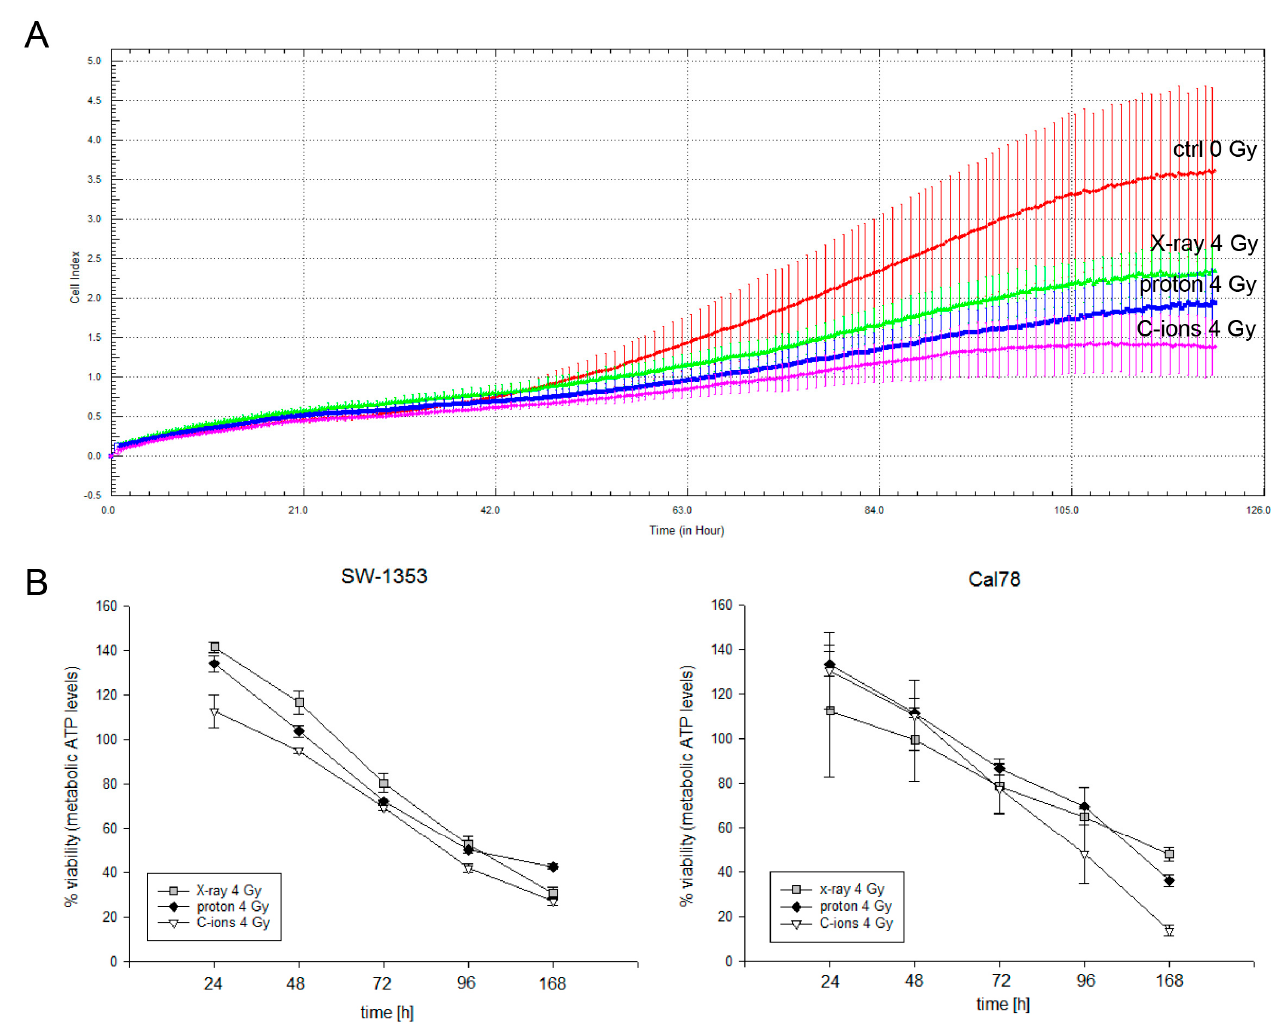
Figure 3. Proliferation and cell viability analysis after 4 Gy X-ray/proton/C-ions IR. ( A ) xCELLigence real-time proliferation analysis (red: non-IR controls; green: X-ray 4 Gy; blue: proton 4 Gy (LET 2.9 keV/ µ m); magenta: C-ions 4 Gy (LET ca. 55 keV/ µ m)); ( B ) the percentage of metabolic ATP levels, which is representative for the viability of the cells (mean ± SD; n = 3; measured in quadruplicates). The direct comparison of the three types of IR showed a slight gradation of the cellular response with the strongest effect with C-ions.